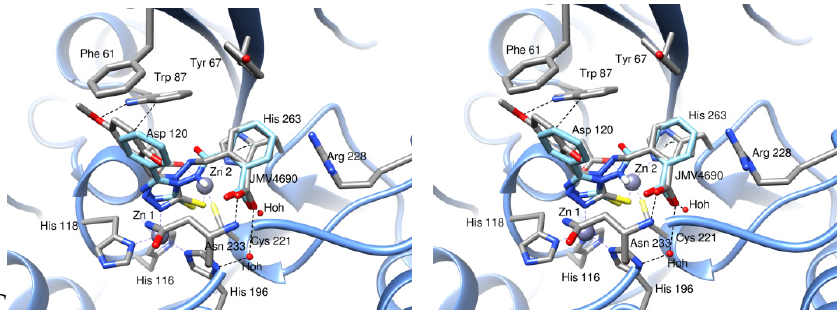
Figure 3. Stereo views showing the binding mode of compounds JMV4390 ( A ), 1 ( B ), and 17 ( C ) in VIM-2 studied by molecular modeling. Compounds (light blue) were superimposed with JMV4690 for comparison. In the case of compound 17 , this pose shows the expected positioning of the carboxylate group within the water pocket but the rigid hydrazide does not allow the N 2 atom of the triazole to correctly coordinate Zn1 (distance of 2.44 Å instead of 1.96–2.19 Å for other compounds, Table S1). The images were produced using UCSF Chimera [54].